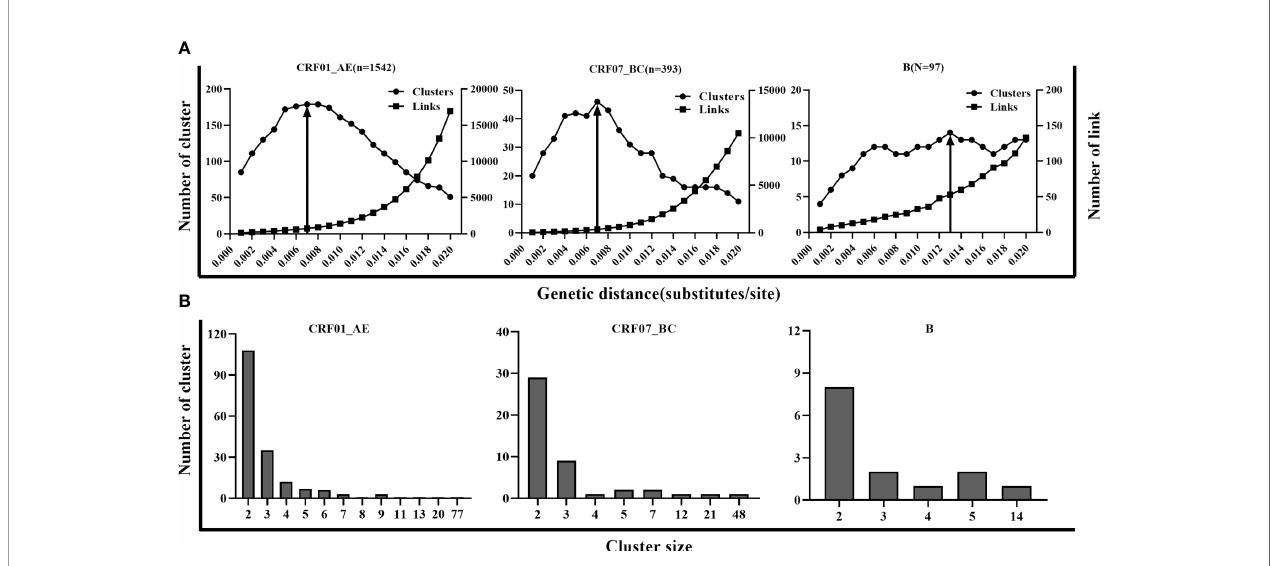
FIGURE 1 | The parameters for inferring molecular network in CRF01_AE, CRF07_BC and B. (A) A systematic sensitivity analysis across the range of GD thresholds (0.001 to 0.020 substitutions/site) for 3 main subtypes. The changes in the number of clusters, the number of edges, and maximum cluster size were showed in CRF01_AE, CRF07_BC, and B separately. The line with an arrow denoted the selected optimal GD thresholds for the 3 subtypes. (B) Distribution of molecular clusters of three main subtypes along with cluster size in the optimal GD threshold.